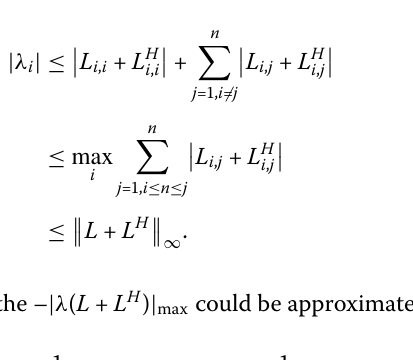
Algorithm (The power method for | λ ( L + L H ) | max